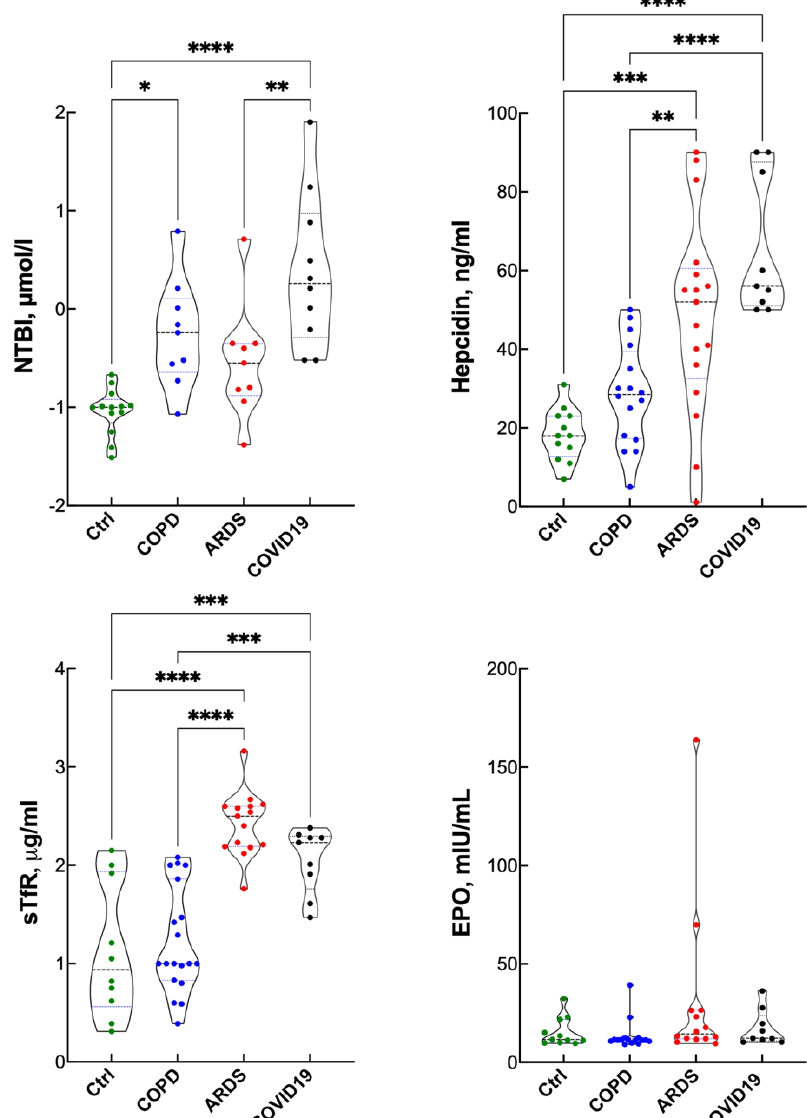
Figure 2. Iron and hematopoietic regulators in controls, COPD, ARDS and COVID-19 (violin plots). ANOVA for EPO was not significant. * p < 0.05; ** p < 0.01; *** p < 0.005; **** p < 0.0001 at the Tukey’s post-test.